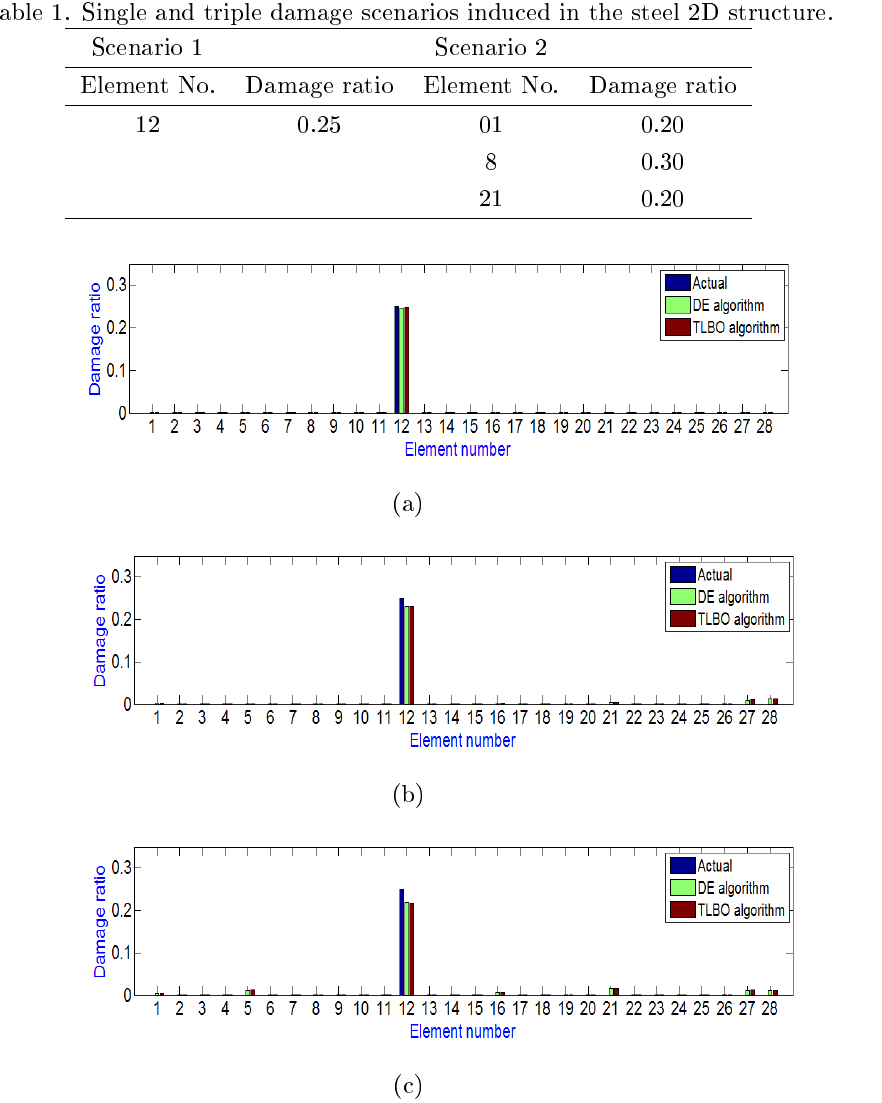
Fig. 2. Comparison of damage detection results obtained from two optimization algorithms for case 1 of the frame: (a) without noise, using 32 translational DOFs; (b) with noise, using 32 translational DOFs; (c) with noise, using 20 translational